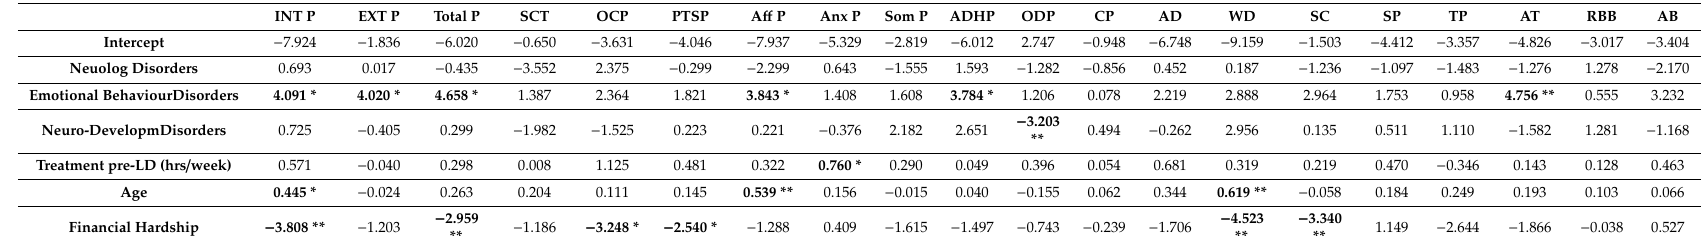
Table 2. Regression models results (6–18